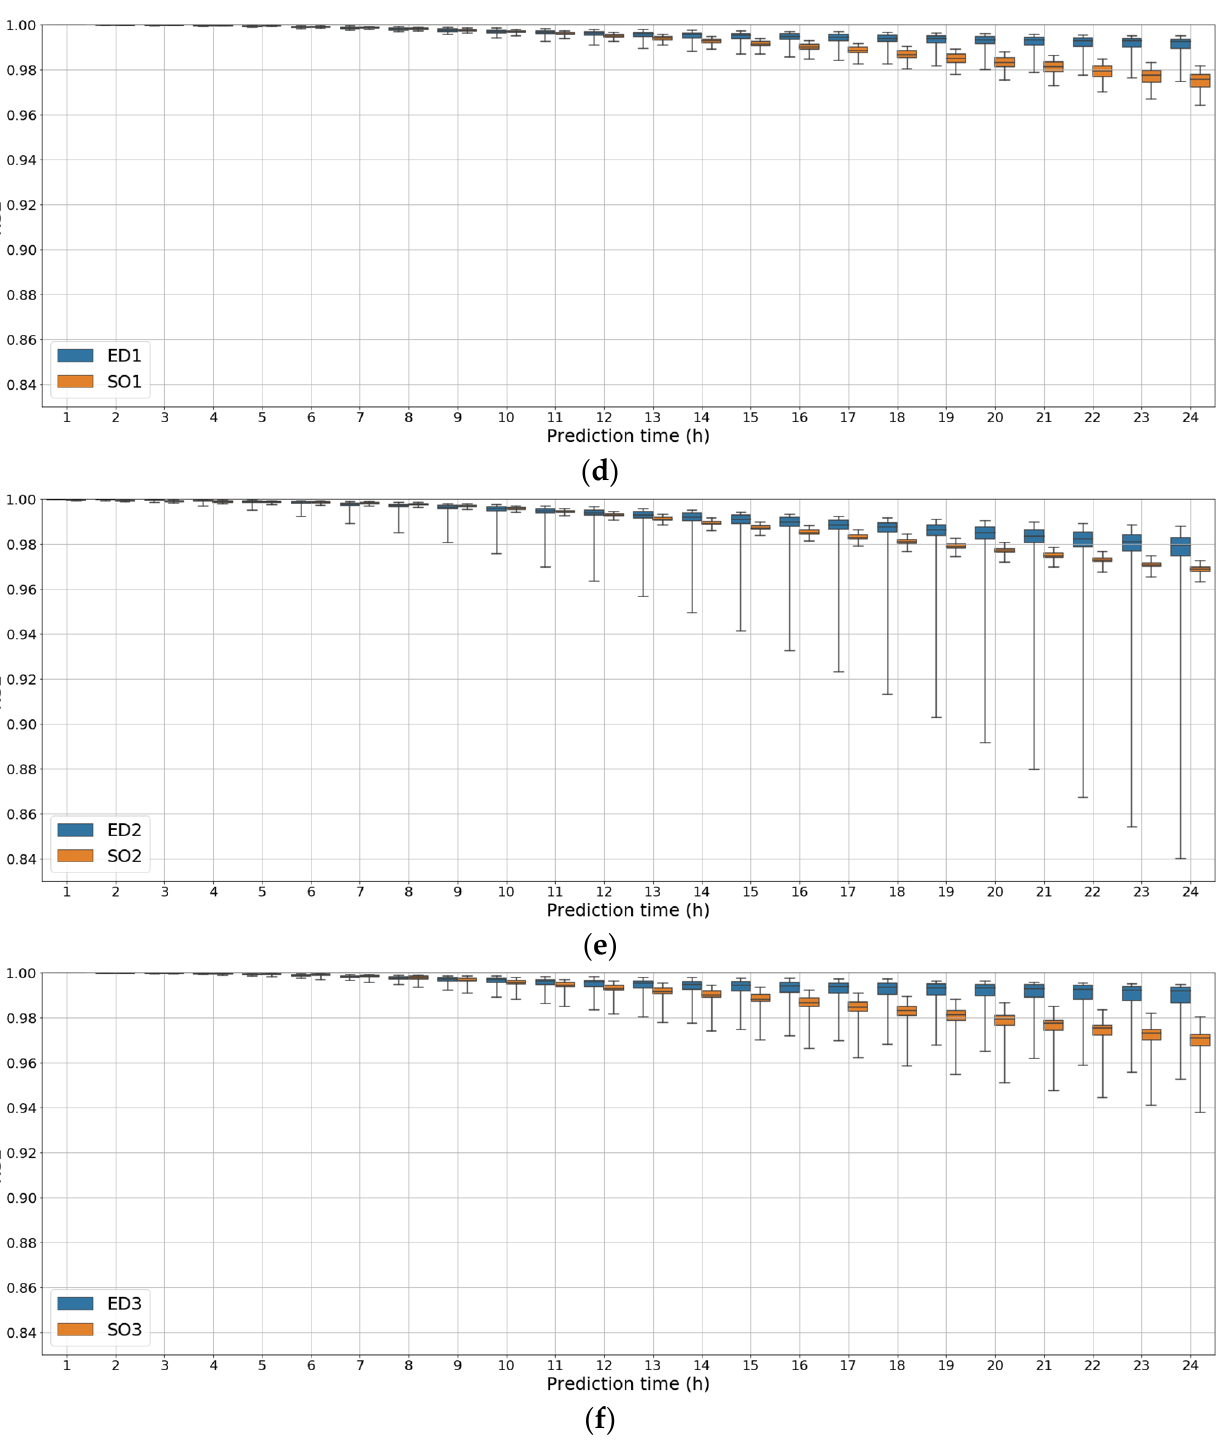
Figure 4. Comparison of the RMSE and NSE values using different output methods for ensemble learning when performing 24 h simulations. ( a – c ) show RMSEs of the output values following simulations with three different models (types 1, 2, and 3, respectively) for both LSTM SO and LSTM ED models. Panels ( d – f ) show NSE indexes obtained using outputs with the same model types.